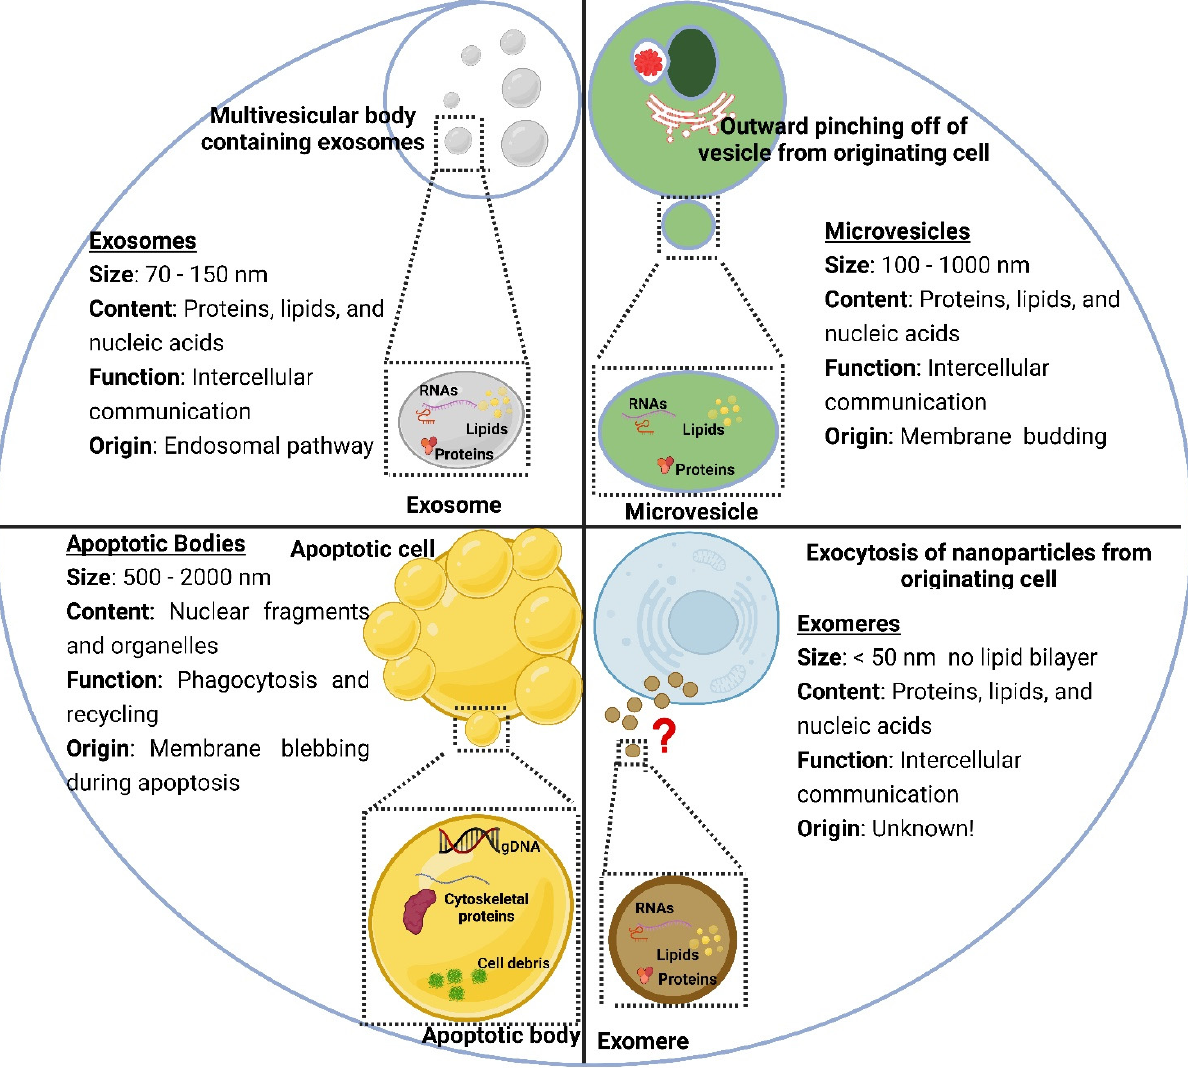
Figure 3. Major subtypes of extracellular vesicles (EVs).